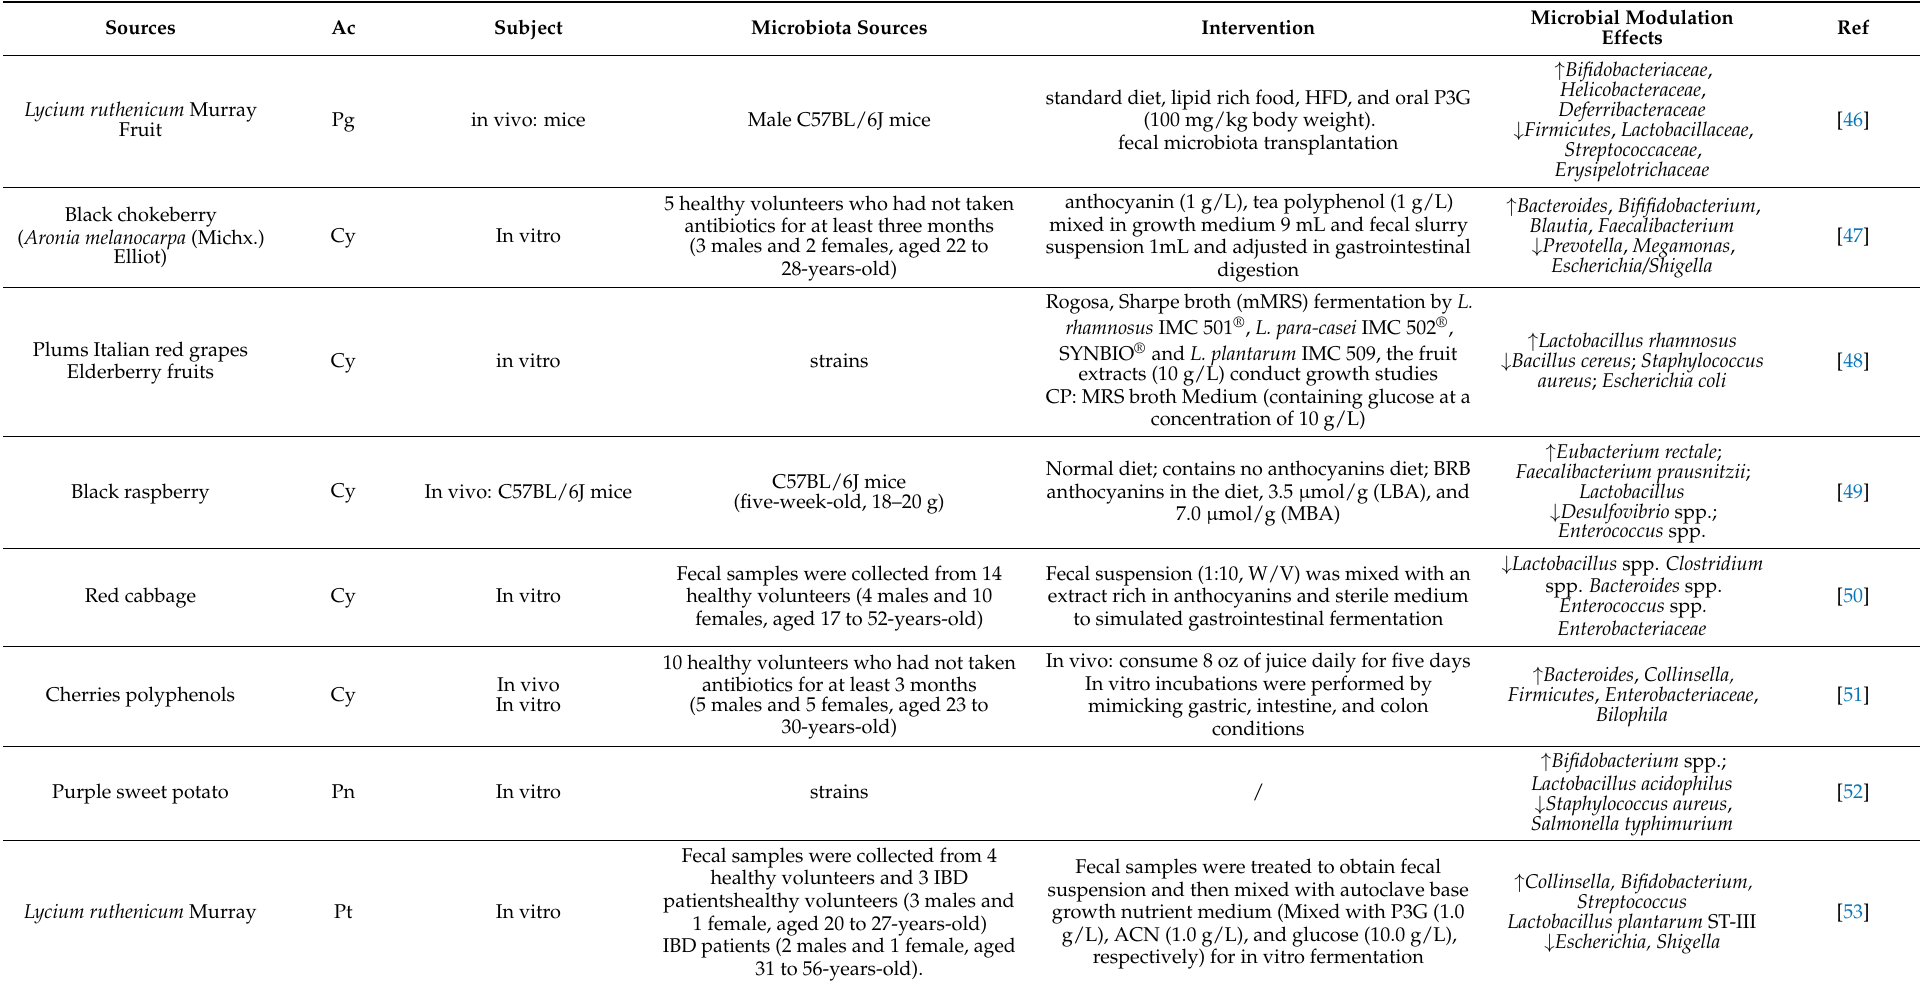
Table 1. Gut microbiome alterations following consumption of anthocyanins rich